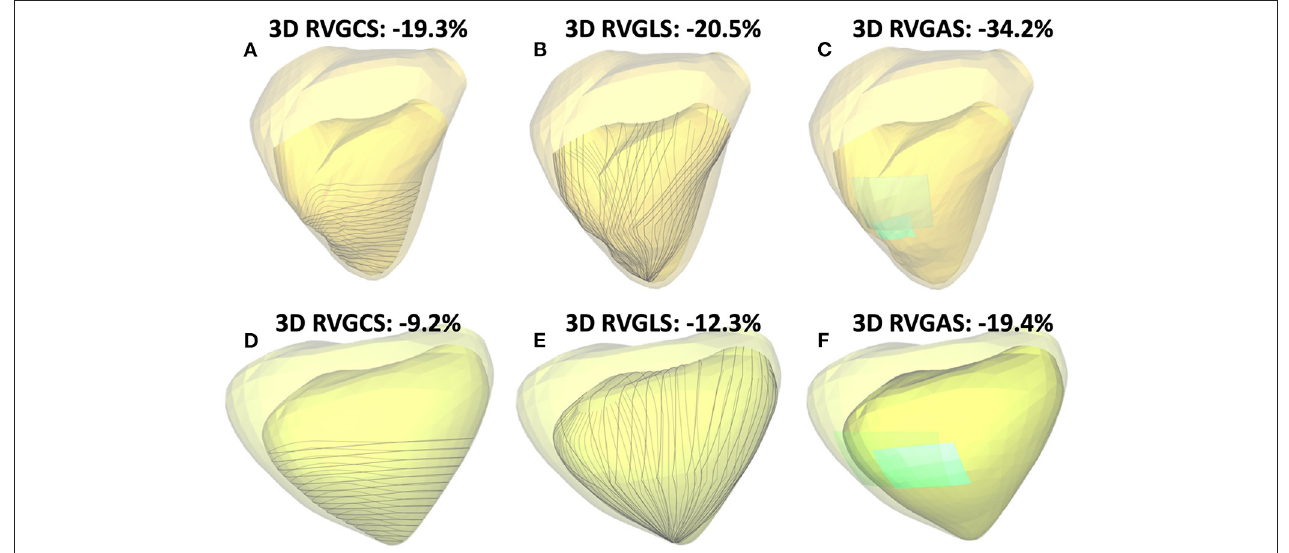
FIGURE 1 | Two representative cases of three-dimensional (3D) right ventricular (RV) analysis using ReVISION software: One case of normal RV function (3D RVEF: 49%, A–C ) and another case of severe RV dysfunction (3D RVEF: 28%, D–F ). Transparent light-yellow and light-green represents the end-diastolic endocardial boundary, and darker yellow and darker green represents the end-systolic endocardial boundary. Gray lines indicate contours used for 3D RV global circumferential strain (RVGCS) (A,D) , and 3D RV global longitudinal strain (RVGLS) (B,E) assessment, respectively. Light-blue segmental areas and their change from end-diastole to end-systole represent the rationale behind area strain calculations [3D RV global area strain (RVGAS) is calculated using entire RV endocardial areas, C,F